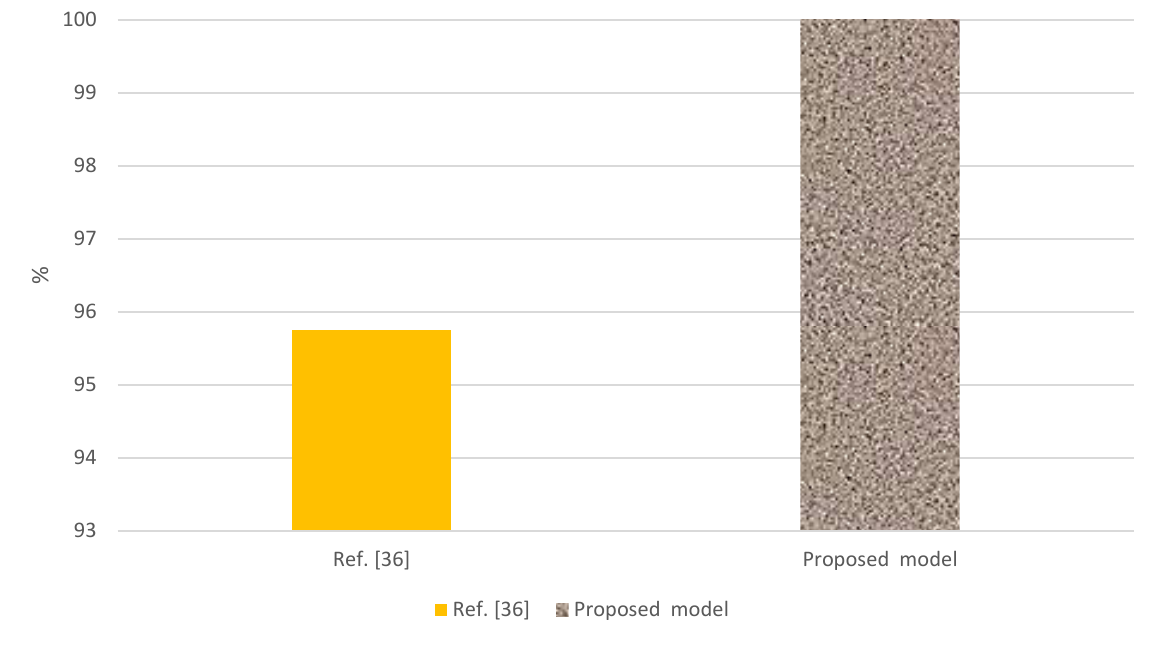
Figure 15. Comparison of the proposed system with the system that developed the dataset.